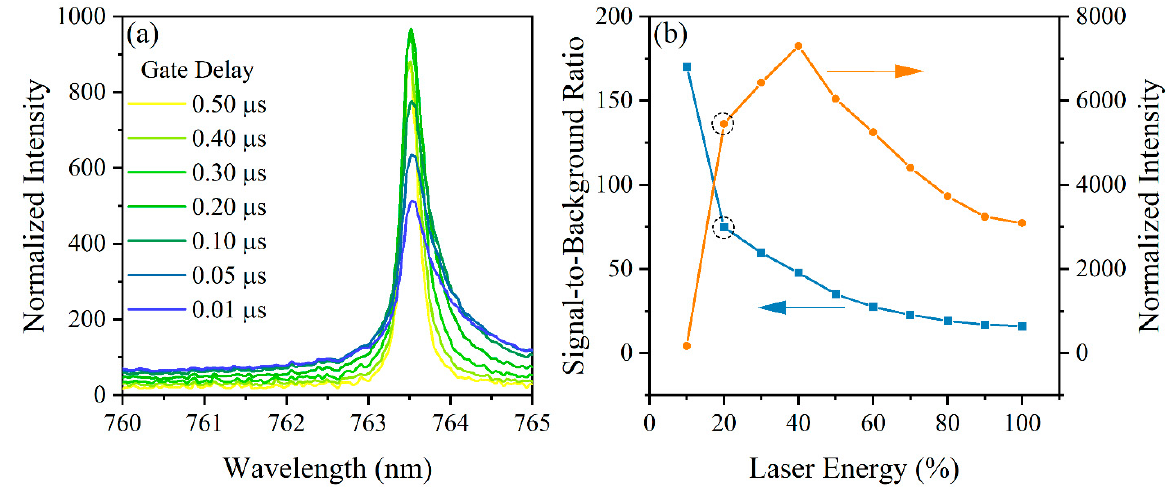
Figure 2. Spectral response of the 763.5 nm Ar I peak versus ( a ) gate delay and ( b ) laser energy. The signal-to-background ratio and normalized peak intensity shown in ( b ) were both considered when selecting the optimal collection settings to be 0.5 μ s delay and 20% laser energy.